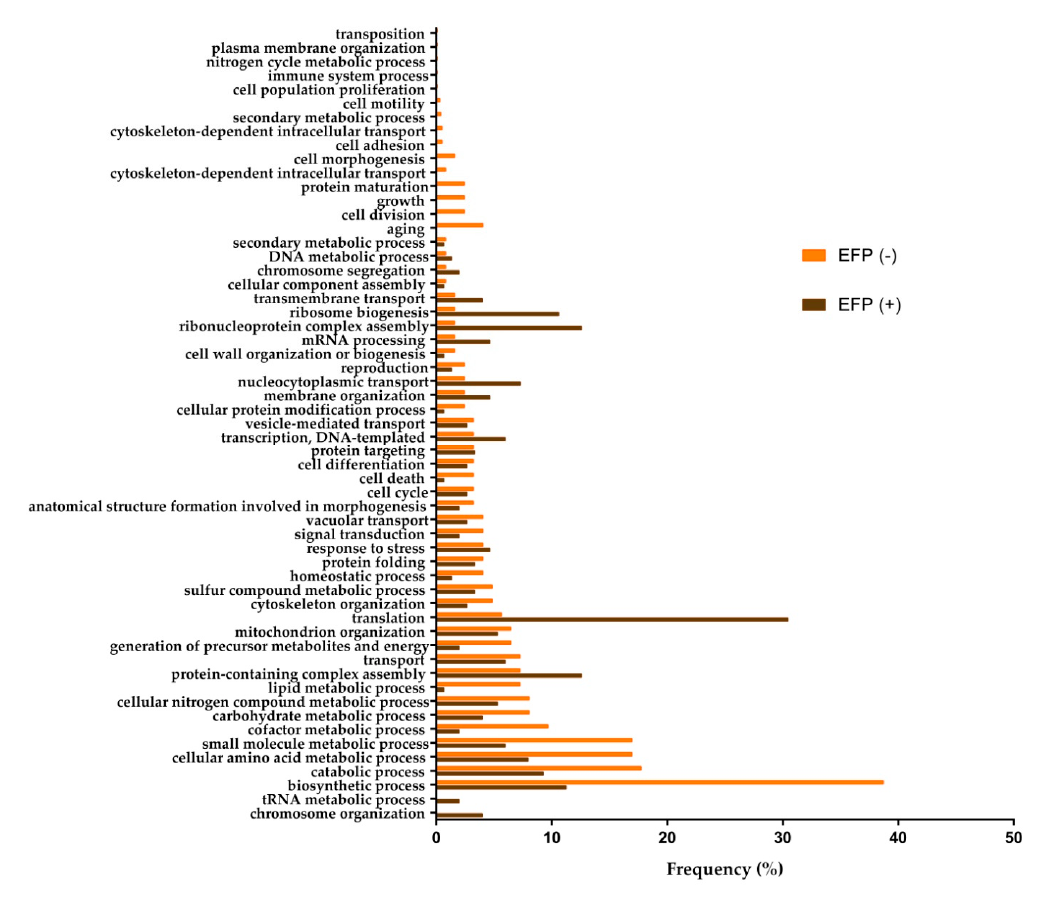
Figure 3. Relevant biological processes at the end of the second fermentation without CO 2 overpressure (EFP ( − ) in orange), and with overpressure (EFP (+) in brown). The frequency (%) of each process corresponds to the number of proteins involved in each process with respect to the total proteins identified.